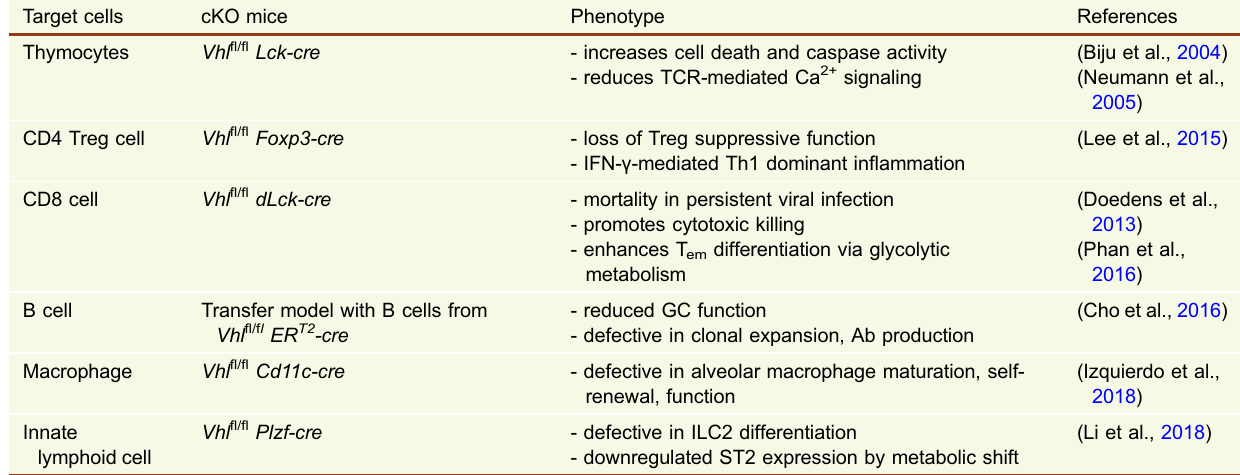
Table 1. The major phenotype of VHL conditional knockout